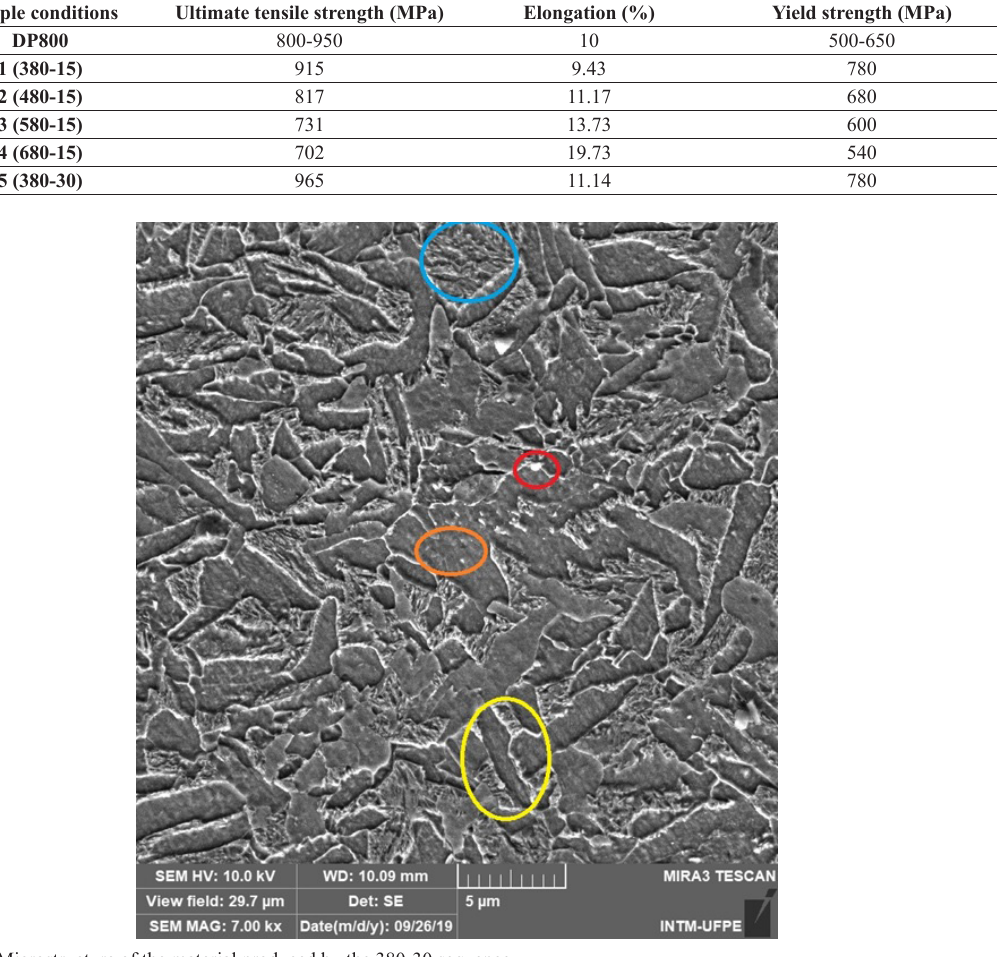
Figure 5. Microstructure of the material produced by the 380-30 (orange circle) microstructure. Traces of the constituent M-A not yet dissolved (red circle) were also observed as seen in Figure 8.